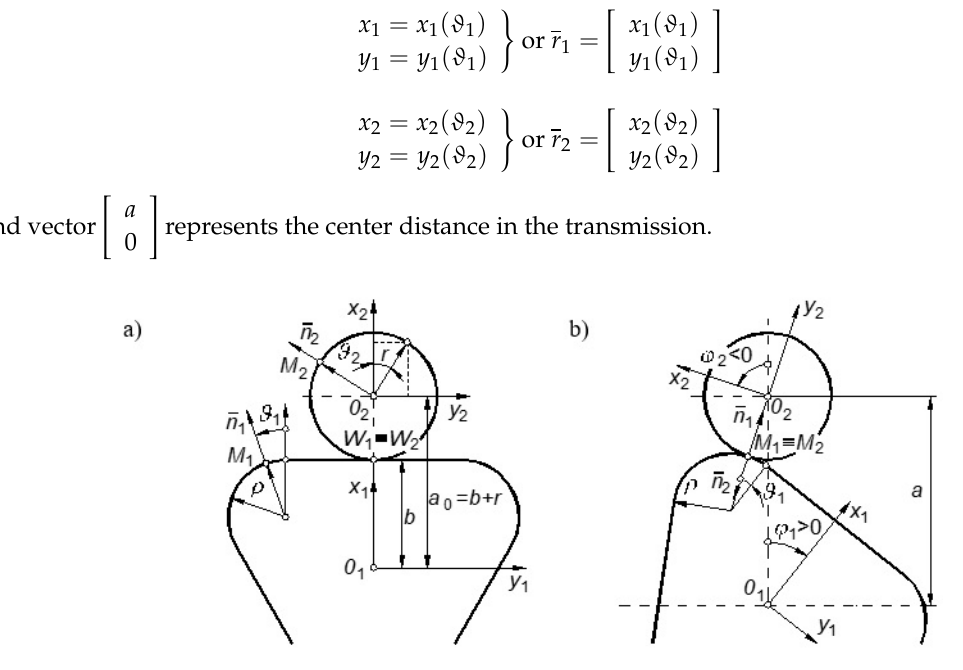
=ϕ Figure 10. The roll curves of a hydraulic motor: ( a ) At the beginning ( ϕ 1 = 0); ( b ) after rotation of the Figure 10. The roll curves of a hydraulic motor: ( a ) At the beginning ( 0 1 ); ( b ) after rotation of triangle rotor by any angle ϕ 1 ϕ [14,15]. the triangle rotor by any angle 1